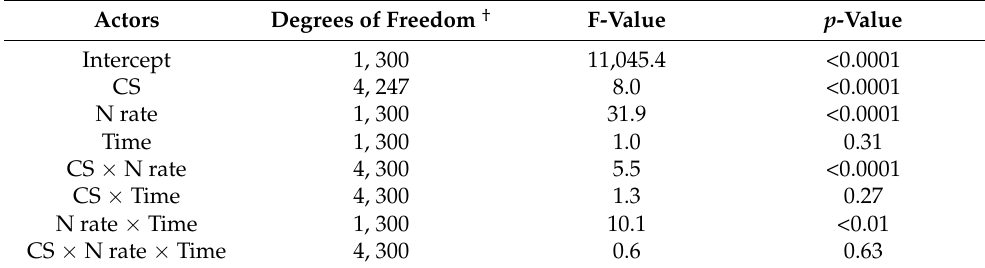
Table 3. Analysis of covariance (ANCOVA) of the effect of cropping system (CS), and N application rate (N rate) on soil organic carbon (SOC) stocks over time.